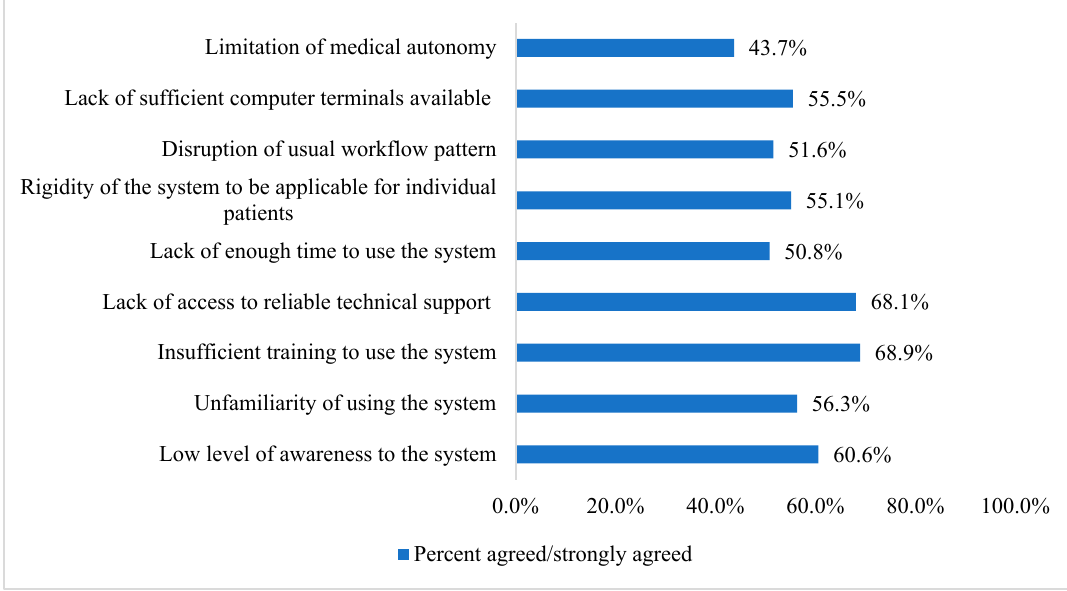
Figure 2. Participants perceived barriers to using electronic prescribing and electronic health record systems in antimicrobial stewardship ( n = 254).